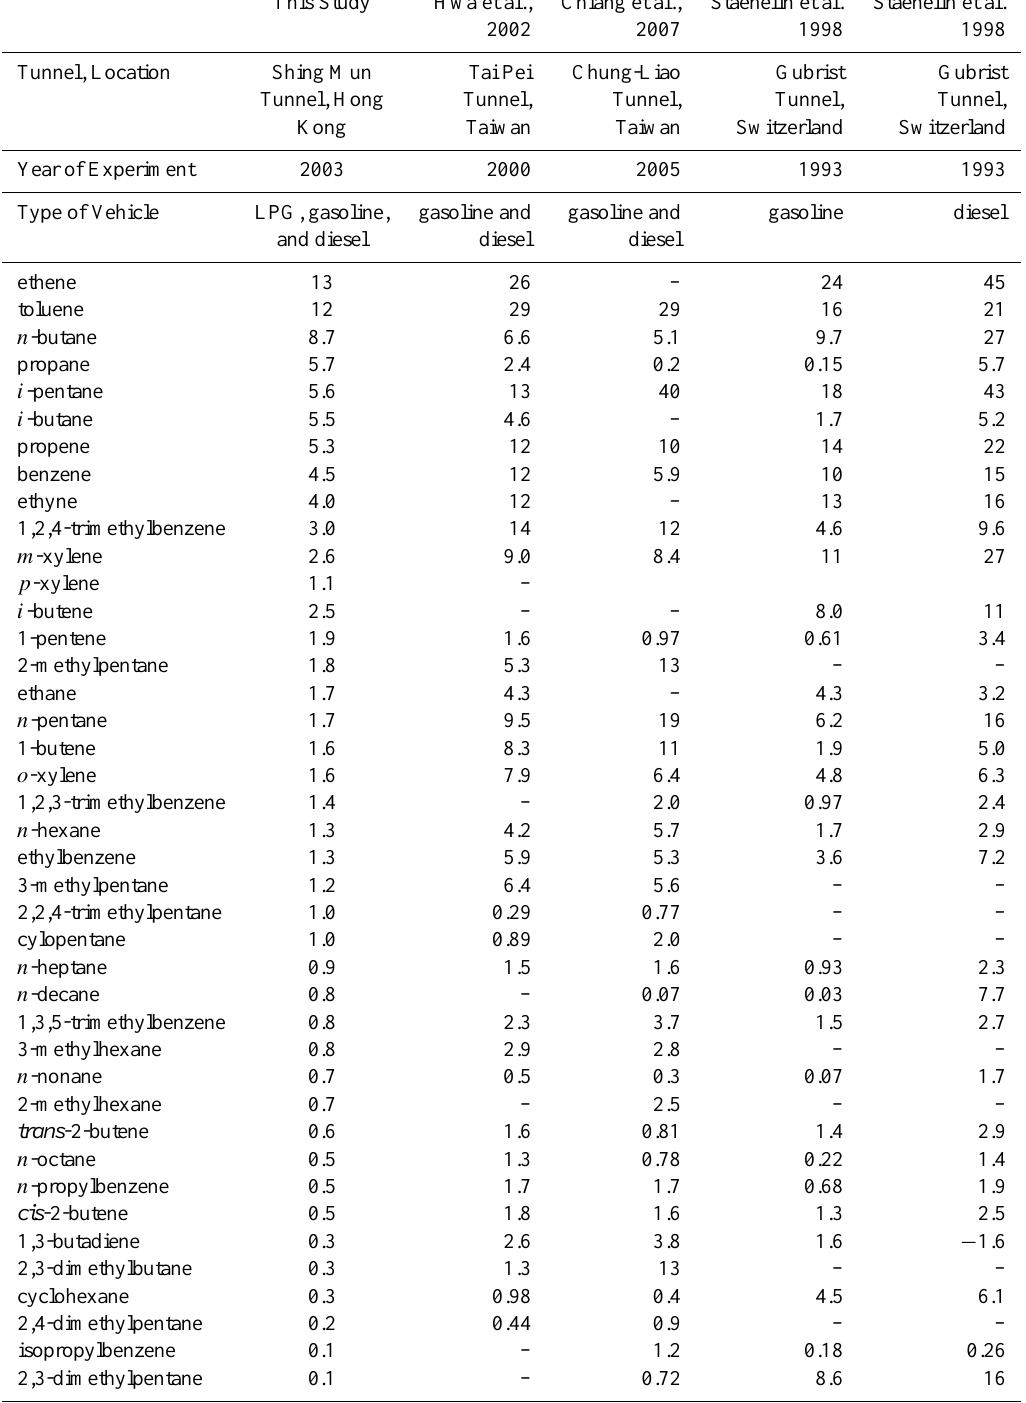
Table 6. Comparison of emission factors of VOCs (mgveh − 1 km − 1 ) with other